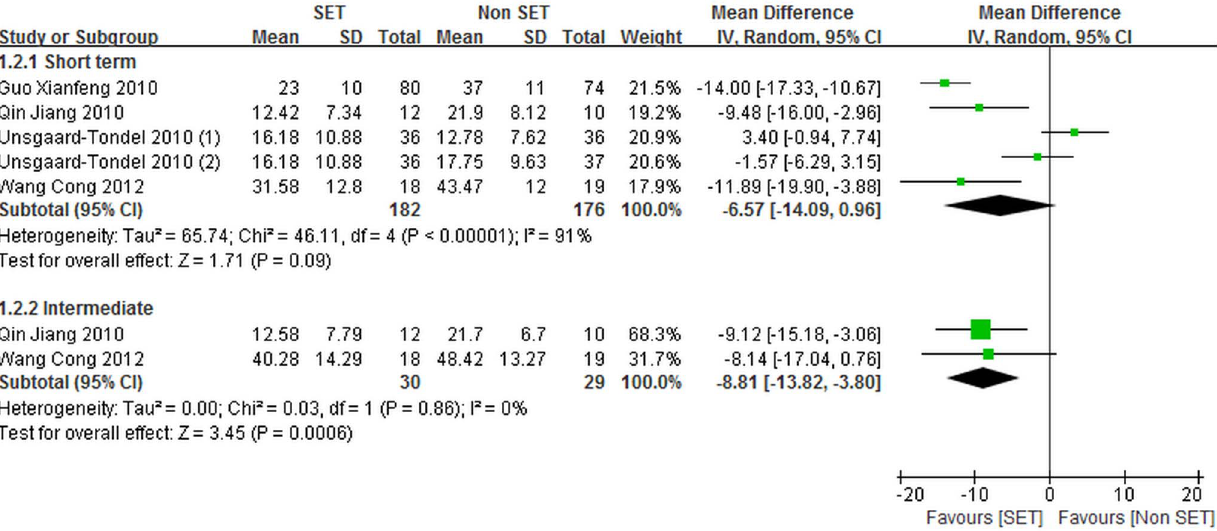
Figure 3. Back pain specific functional status for sling exercise versus other forms of exercise. Unsgaard-Tondel 2010(1), sling exercise versus motor control exercise; Unsgaard-Tondel 2010(2), sling exercise versus general